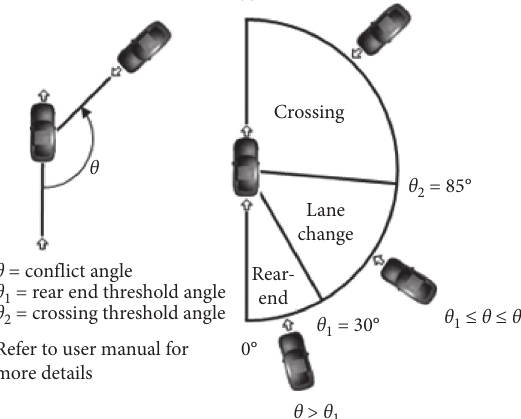
Figure 5: Classification of conflict type in SSAM